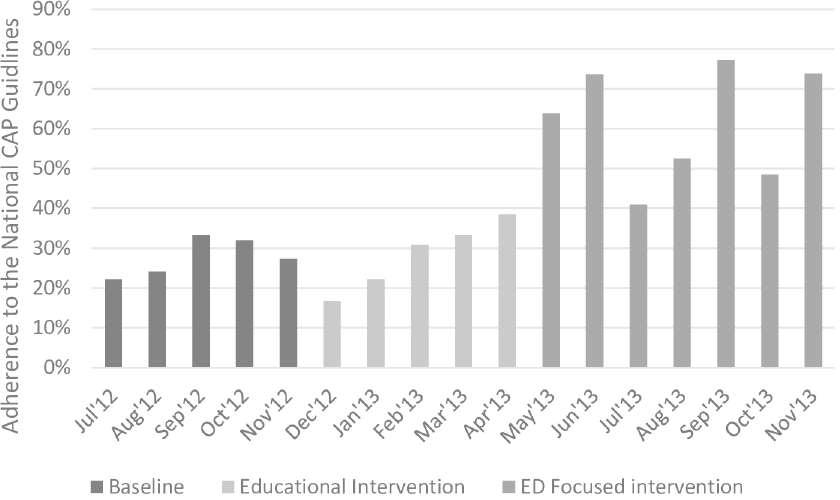
Fig 1. Impact of the General Education and ED Focused intervention on the physicians ’ adherence to the national CAP guidelines. Fig 1 summarises the adherence rates to the national CAP guidelines recommendations for the empirical management of CAP between July 2012 and November 2013. During this period, two interventions were implemented. General education intervention that was implemented during mid-December, 2012 to mid-February 2013 with follow-up period till the end of April, 2013 and ED focused intervention that includes a clinical pathway implemented from May 2013, supplemented by monthly audit and feedback (last feedback provided on October,